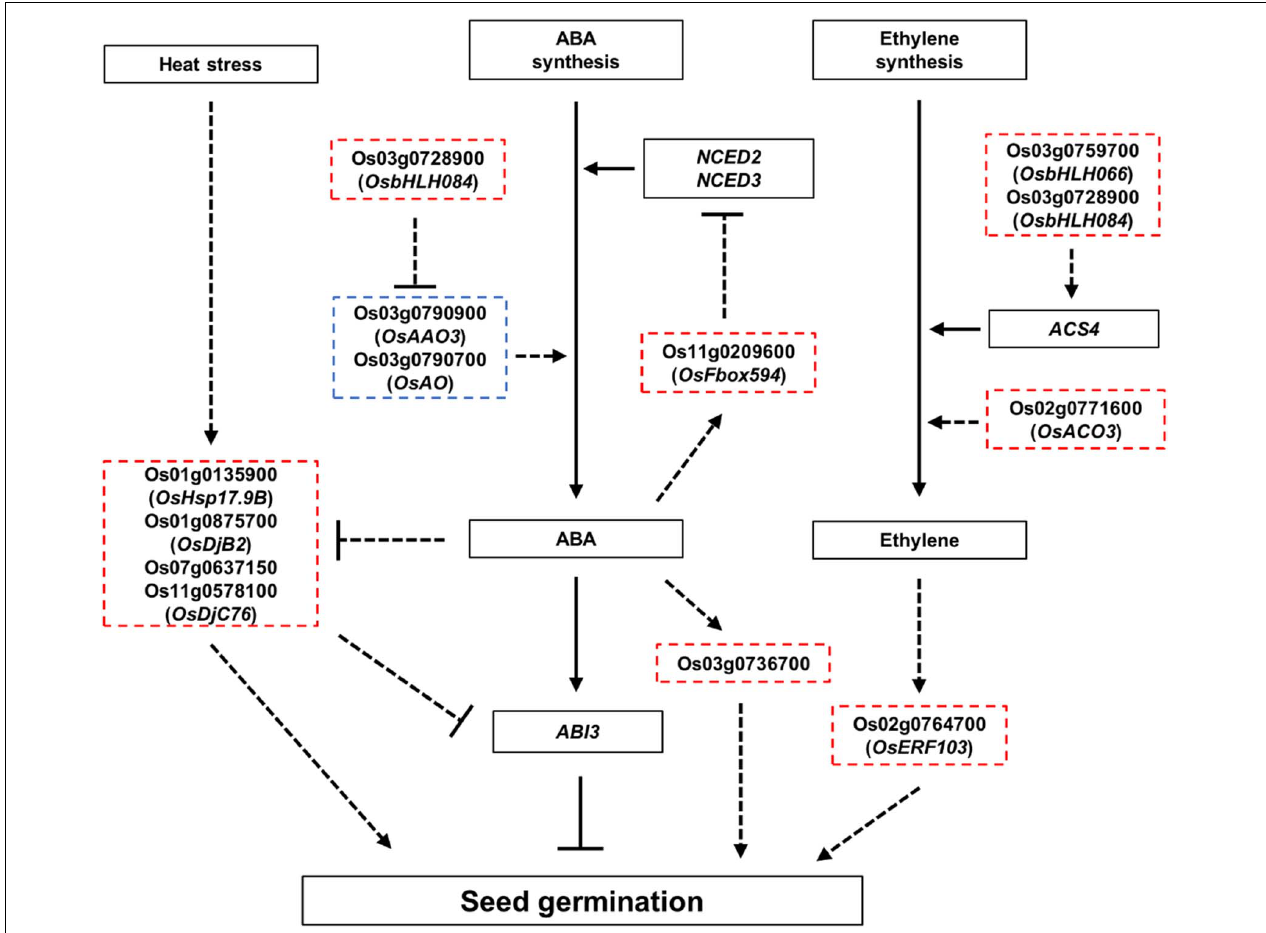
FIGURE 7 | Proposed model showing the role of ABA, ethylene, and HSPs in seed germination. Red and blue dashed boxes indicate genes expected to positively and negatively regulate the seed germination, respectively. Arrows indicate positive regulation, and bars indicate negative regulation. Bold lines indicate gene functions supported by strong evidence, and dashed lines indicate gene function with limited evidence in seed germination, which requires further